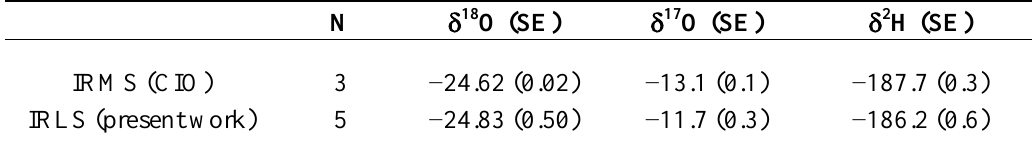
Table 2. IRLS vs. IRMS: measurement accuracy comparison of isotope ratios in water reference GS-42. Where SE = SD/N 1/2 , is the standard error of the mean values for N measurements. IRLS results were obtained using 1 s Kalman filtering with q =